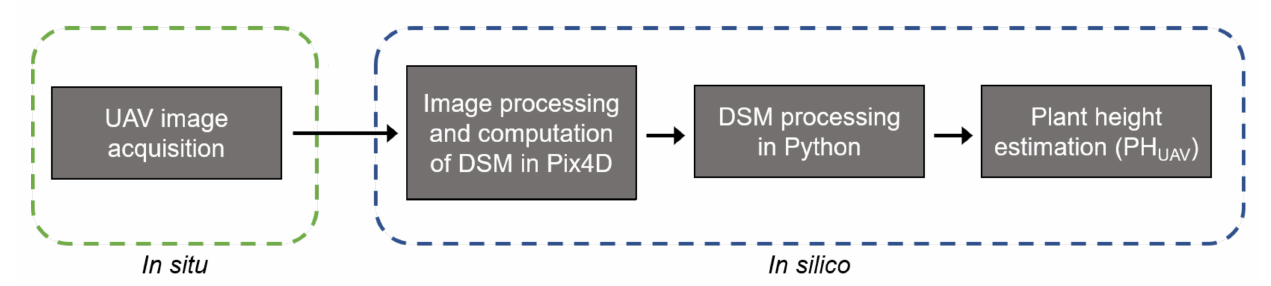
Figure 2. General overview of the methods applied for UAV-based plant height estimation; DSM: digital surface